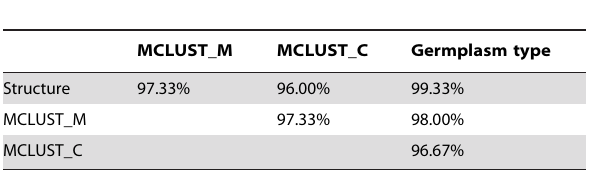
Table 3. Correspondence of the assignments by different methods and the germplasm